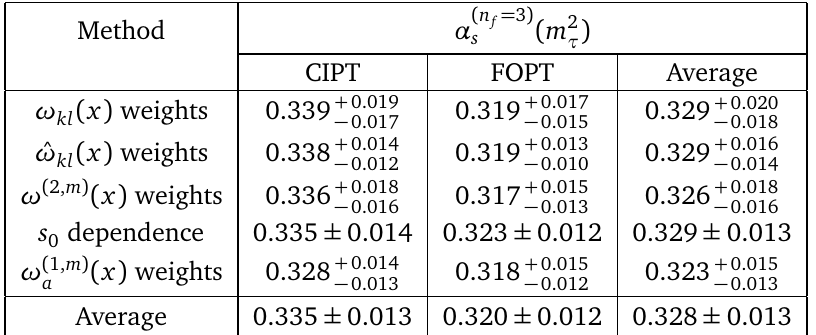
( n = 3 ) ( m 2 ) from τ decay data, in the V + A channel [ 16 ] f τ s